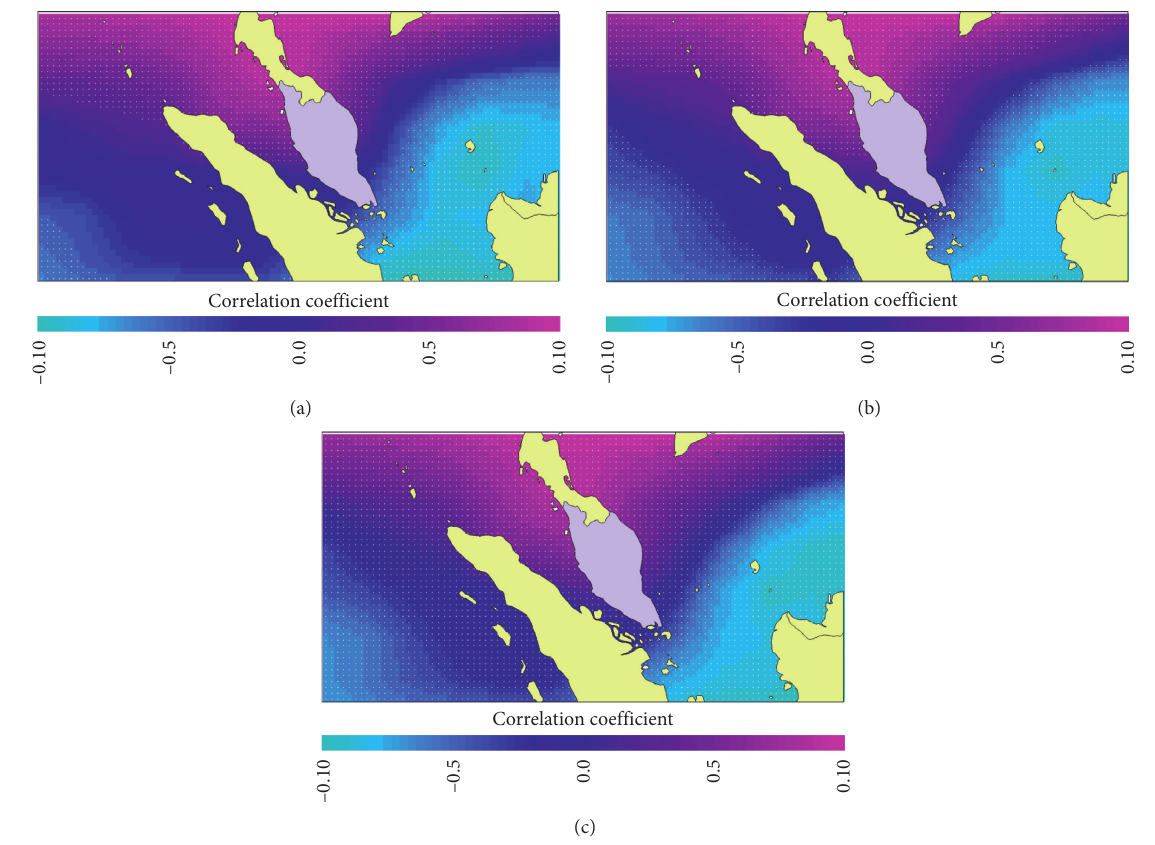
Figure 7: Correlation of areal average rainfall in the East Coast of Peninsular Malaysia with sea level pressure at different locations for (a) 1-day; (b) 2-day, and (c) 3-day lags. The colour ramp is used to show the positive (negative) correlation. The significant correlation ( p < 0.05) is presented using white dots.